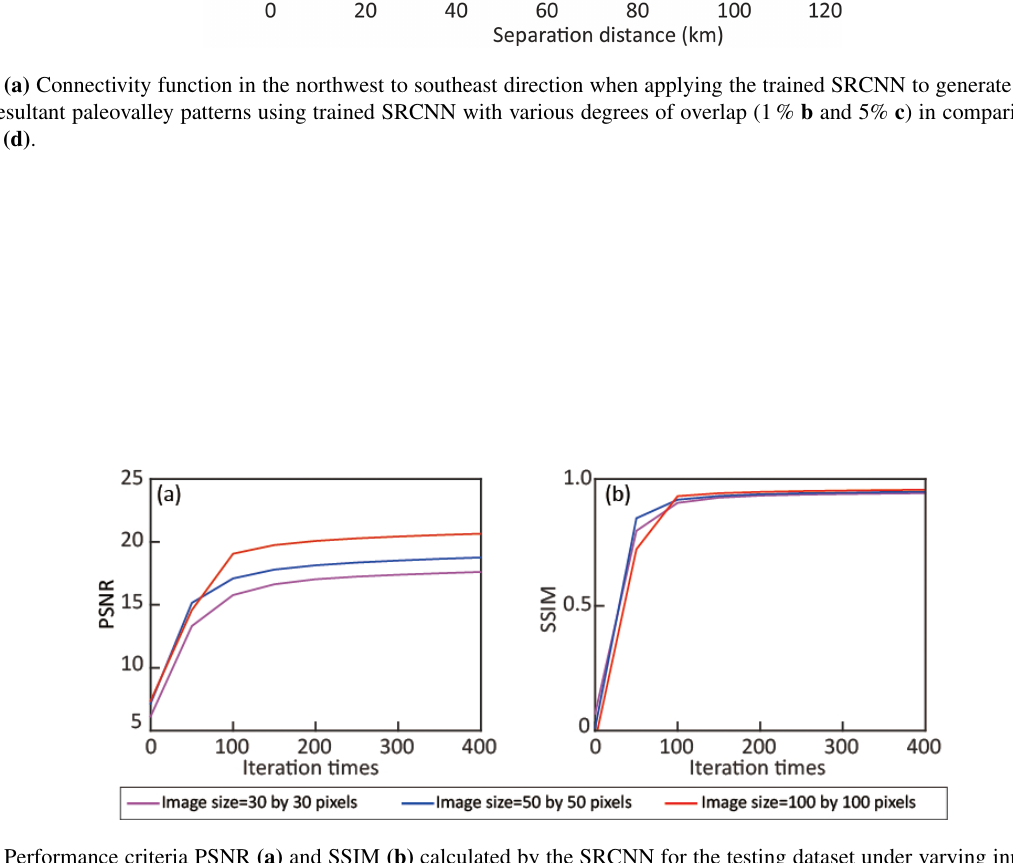
Figure A4. Performance criteria PSNR (a) and SSIM (b) calculated by the SRCNN for the testing dataset under varying input image sizes (30, 50 and